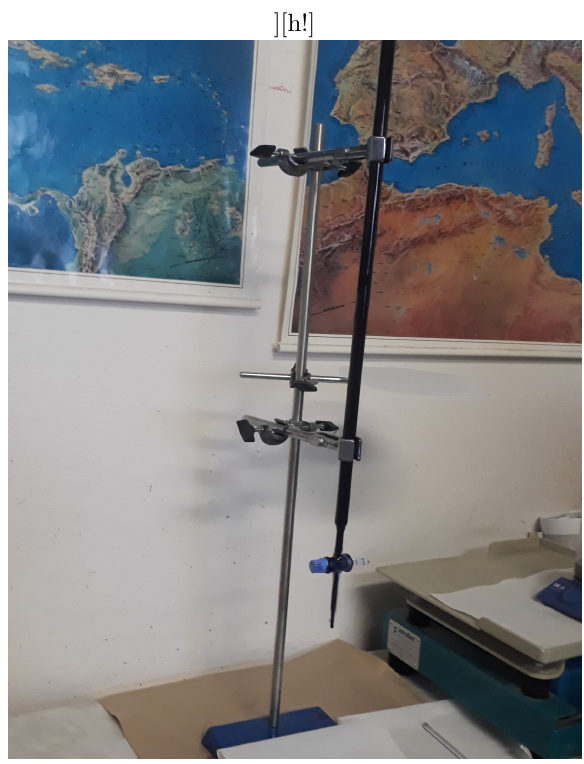
Figure 2. Burette with methylene blue solution.